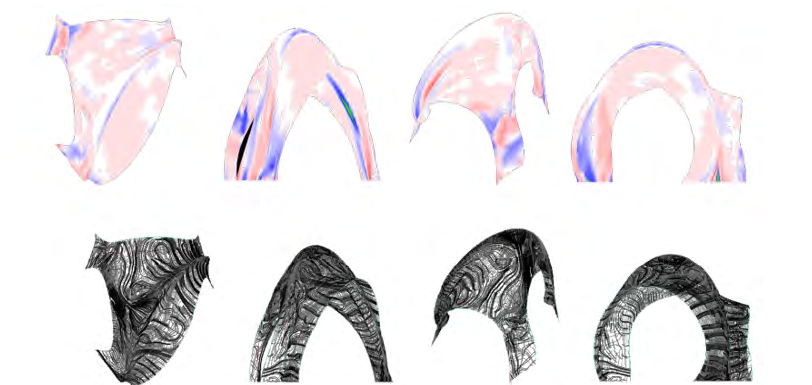
Figure 11. Karamba structure analysisof case study two from IAAC showing the compression and tension areas. Blue istension, Red is compression. / Karamba structure analysis of case study two from the IAAC showing the stress lines of the shell structure.